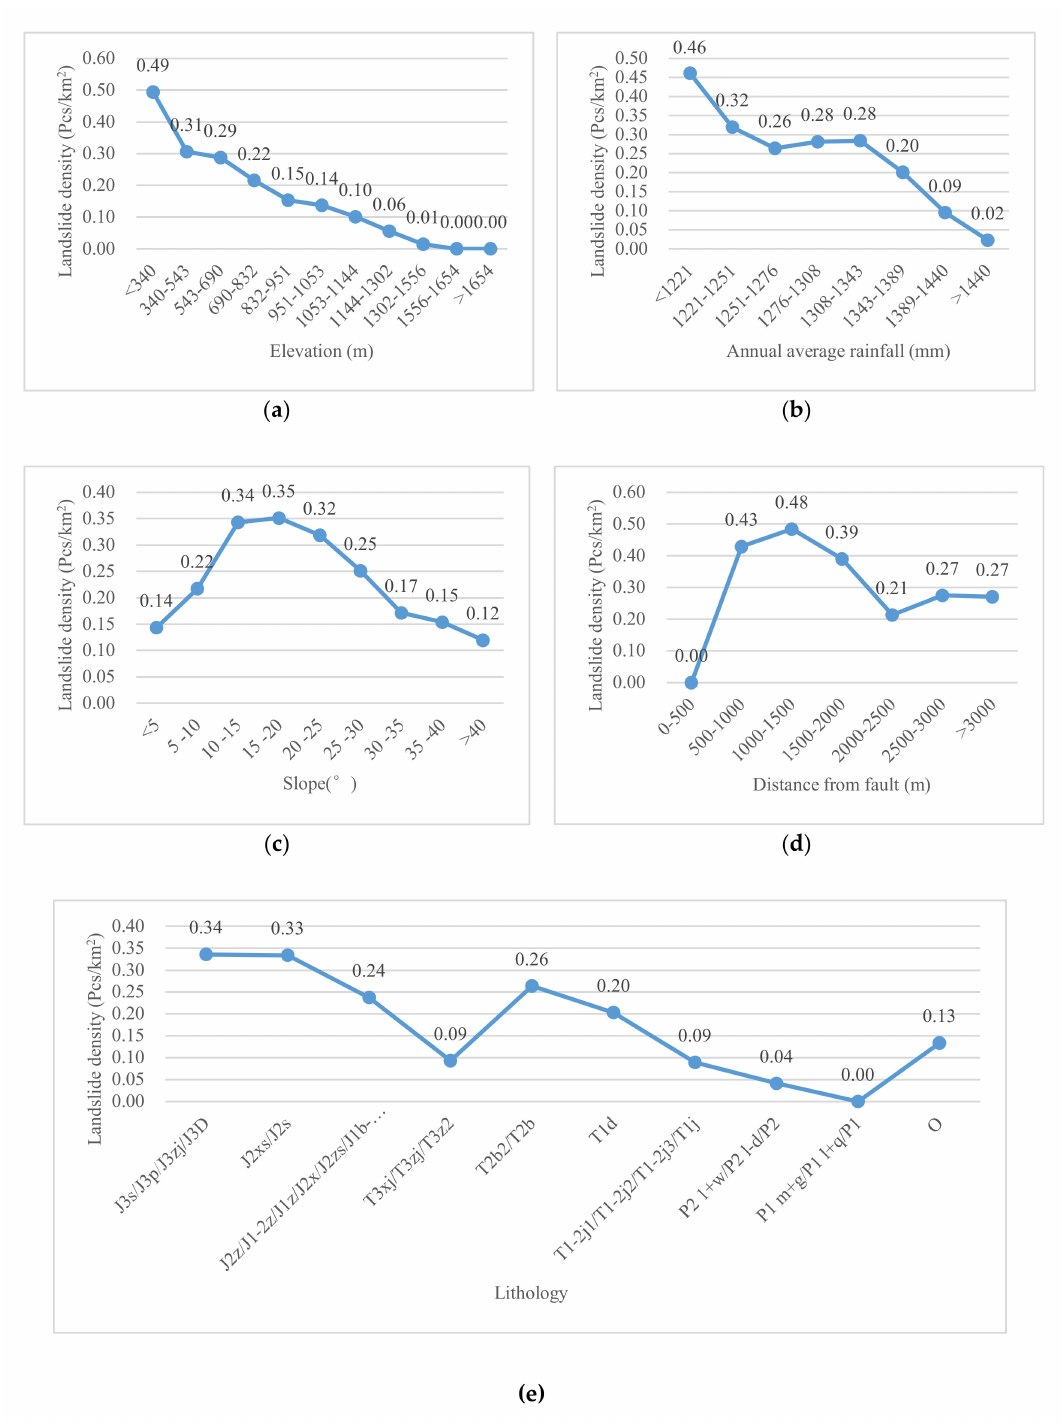
Figure 21. Typical factors in landslide density statistics: ( a ) Elevation; ( b ) Annual average rainfall; ( c ) Slope; ( d ) Distance from faults; ( e )